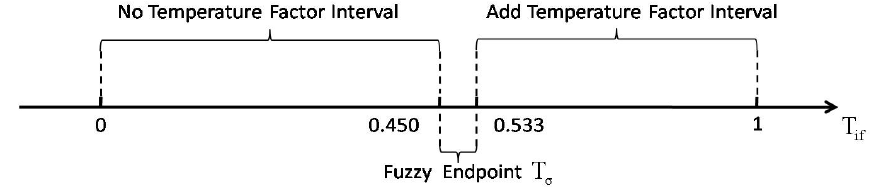
Figure 5. Significance map of temperature influence coefficient.